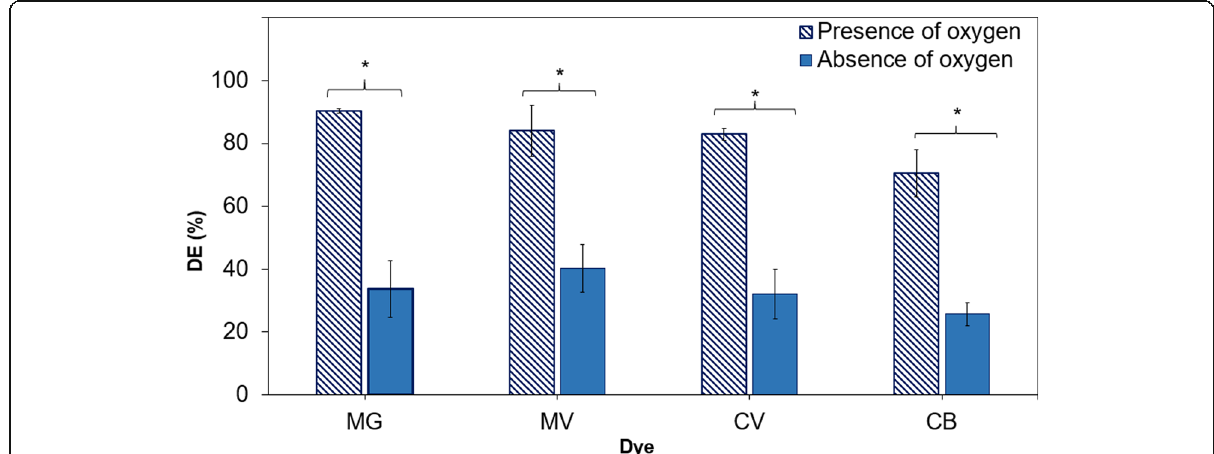
Fig. 8 Effect of oxygen on the DE of TPM dyes by Streptomyces isolate. ‘ * ’ indicates significant difference based on paired T -test ( p < 0.05) between aerobic and anaerobic condition. Bars indicate ± SEM